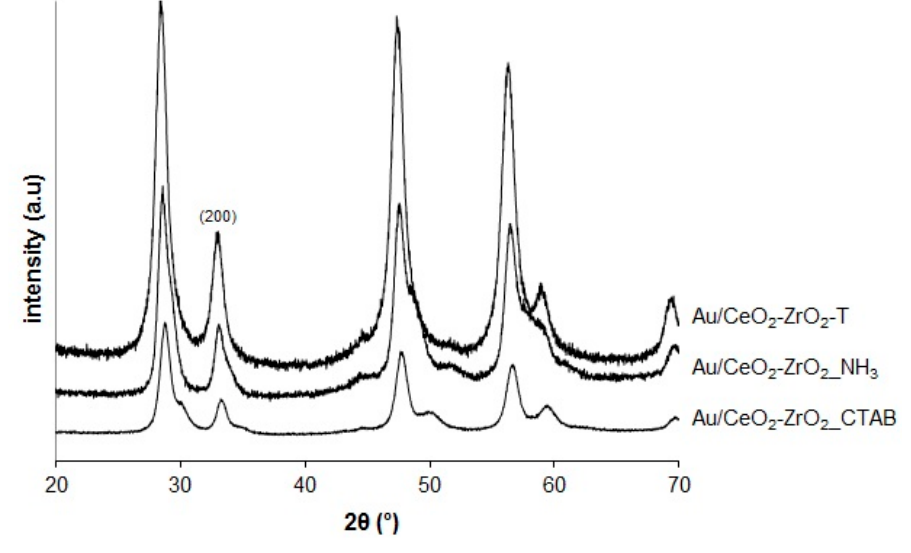
Figure 2. X-Ray Diffraction (XRD) of Au-supported samples.